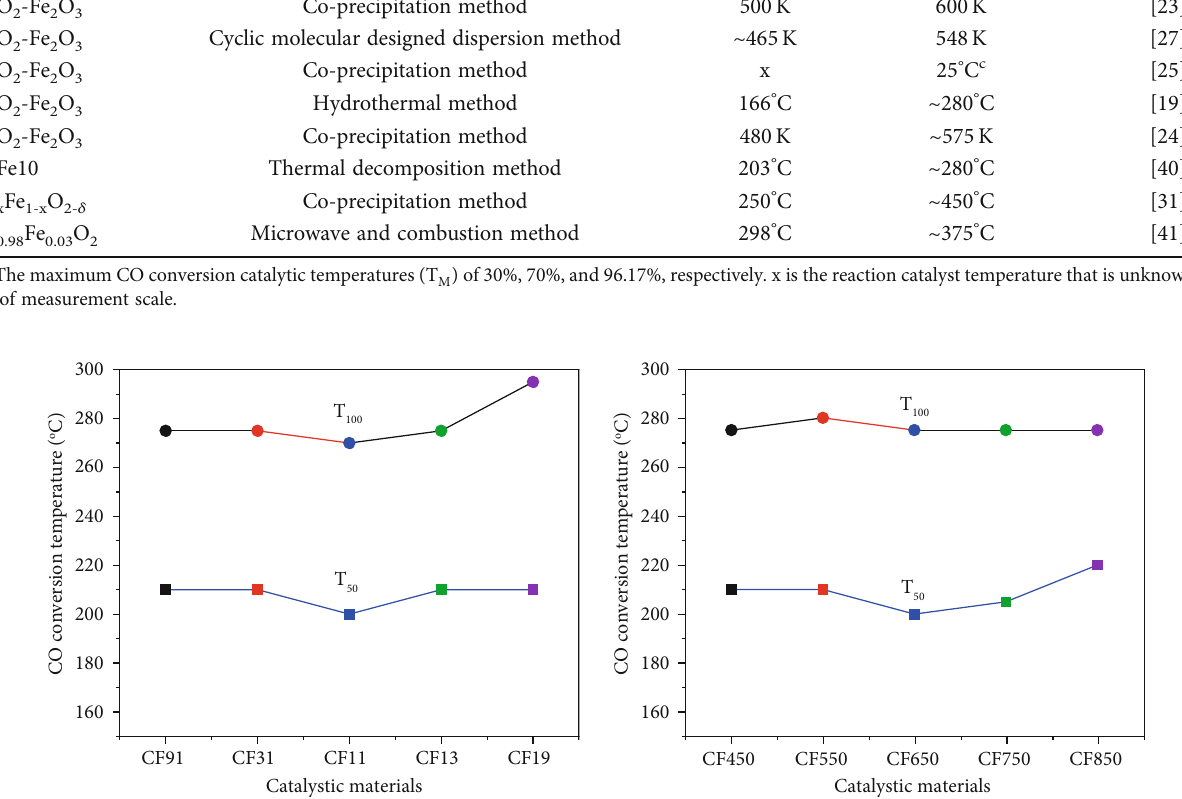
ff erent CF molar ratios calcined at 650 ° C for 2 h (a) and